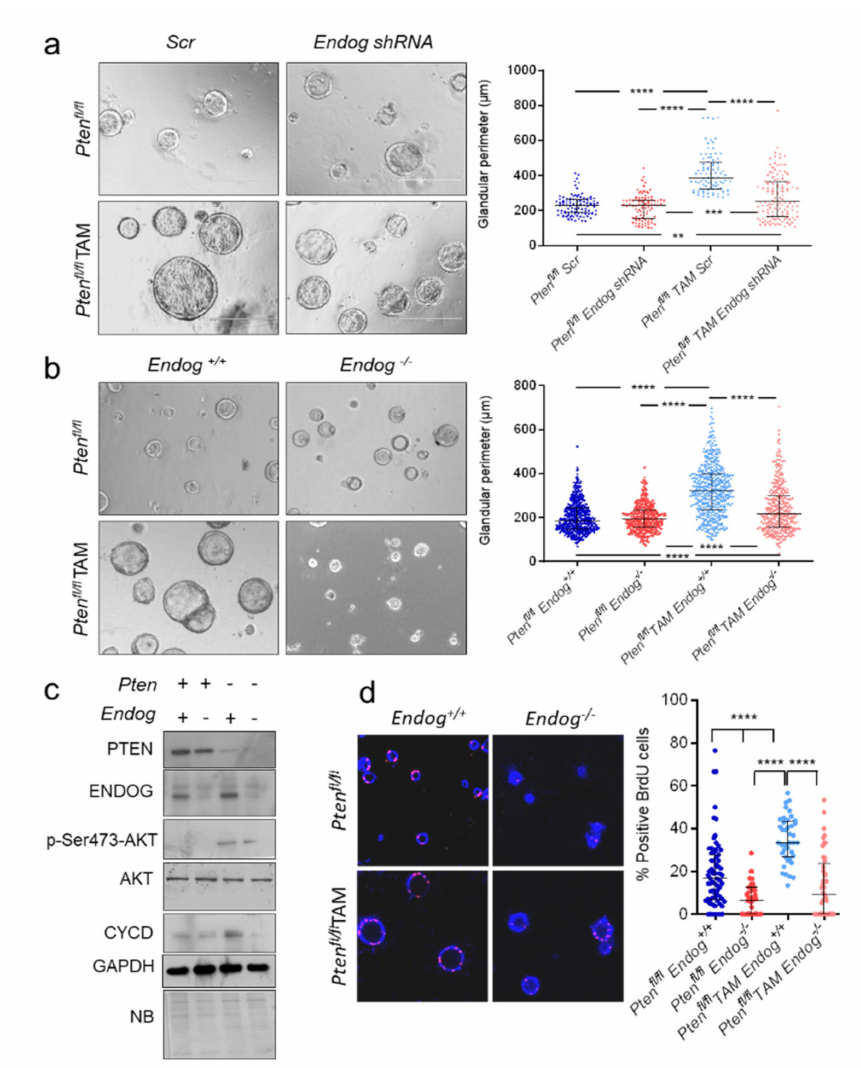
Figure 3. ENDOG deficiency prevents tumor growth induced by PTEN deletion in polarized en- dometrial epithelial 3D cell cultures. ( a ) Representative phase contrast microscopy images of Pten - expressing Pten fl/fl or Pten -deficient Pten fl/fl + tamoxifen (TAM) endometrial epithelial 3D cultures transduced with scrambled (Scr) or Endog shRNA lentiviral particles. Scale bar: 200 µ m. Dot plot graph shows all individual measurements of the glandular perimeter obtained in an experiment per- formed in triplicate plates. Bars show median ± interquartile range. Kruskal–Wallis test followed by Dunn’s test was performed. ****, p < 0.0001. ( b ) Representative phase contrast microscopy images of endometrial epithelial 3D cultures obtained from Pten fl/fl / Endog +/+ or Pten fl/fl / Endog − / − ± tamoxifen (TAM). Images are obtained at the same magnification as in ( a ). Dot plot graph shows all individual measurements of the glandular perimeter obtained in three independent experiments performed in duplicate plates. Bars show median ± interquartile range. Kruskal–Wallis test followed by Dunn’s test was performed. ****, p < 0.0001; ***, p < 0.001; **, p < 0.01. ( c ) Expression analysis of relevant genes was performed in total protein extracts of the cultures described in ( b ). NB: Naphthol blue staining of the membrane. ( d ) Representative fluorescence microscopy images of BrdU incorporation in endometrial epithelial 3D cultures obtained from Pten fl/fl / Endog +/+ or Pten fl/fl / Endog − / − ± tamox- ifen (TAM). Pink: BrdU, blue: Hoechst nuclear staining. Dot plot graph shows the percentage of BrdU-positive cells obtained in three independent experiments performed in duplicate plates. Bars show median ± interquartile range. Kruskal–Wallis test followed by Dunn’s test was performed. ****, p <